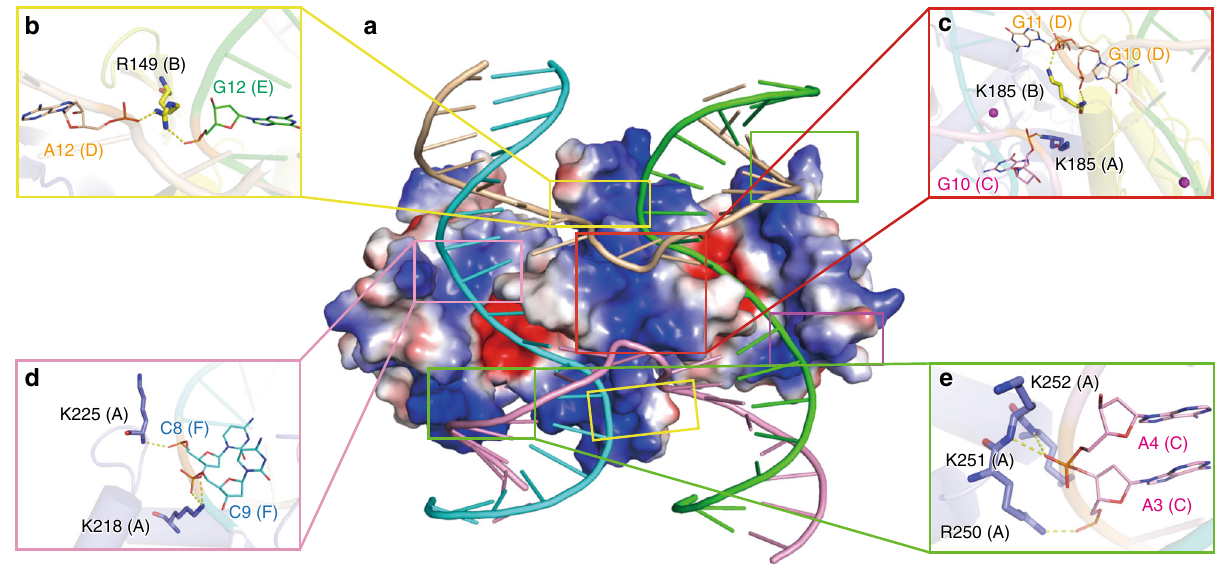
Fig. 4 Protein-DNA contacts. a The bottom view of the complex shows the interaction surface. The protein dimer is shown by the electrostatic surface potential. Four DNA strands of the HJ are shown with cartoon illustrations. Four distinct interaction regions are labeled with colored rectangles. b – e Enlarged image showing the details of the interaction between NtMOC1 and the DNA strands. Capital letters in parentheses indicate corresponding protein or nucleotide chains. A and B represent protomer A and B; C, D, E, and F represent DNA strands C, D, E and F,